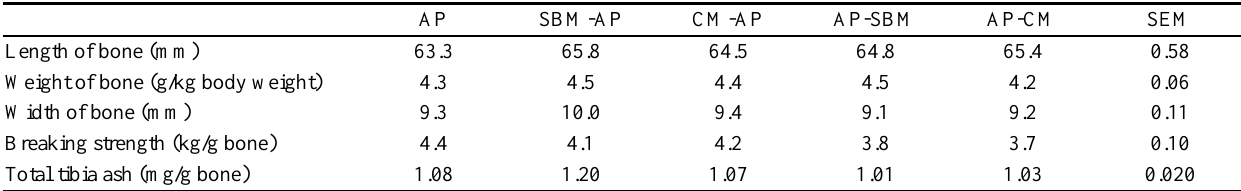
Table 6. Bone (tibia) characteristics of broiler chickens from different feeding regimes at 21 days of age AP